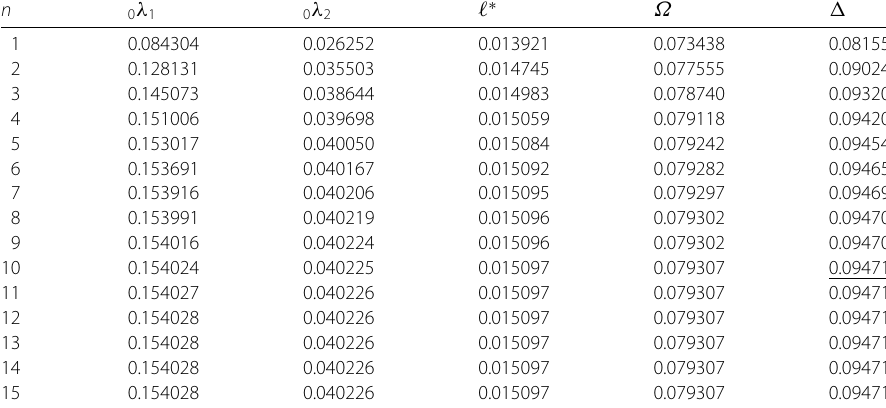
and n = 15 of Algorithm 6 3